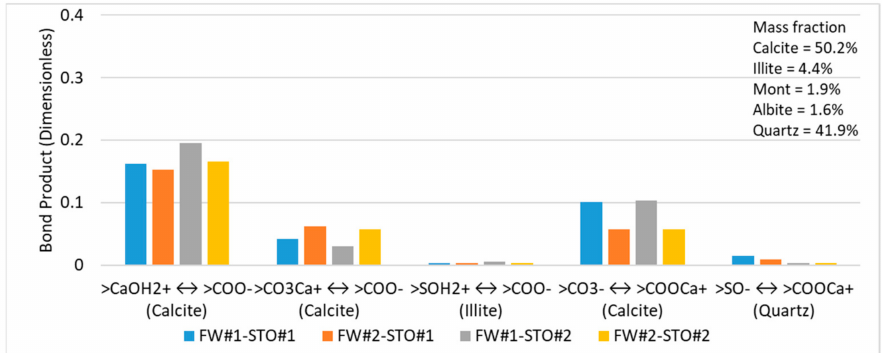
Figure 8. Bond product (oil adhesion mechanism) of PSR#4 during FWI.